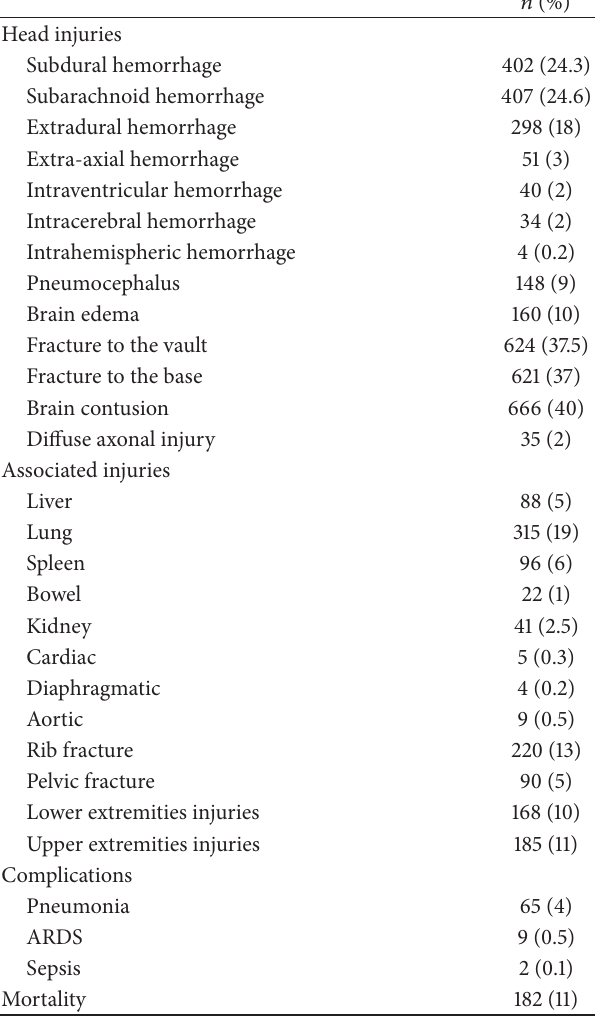
Table 2: Traumatic brain injuries and associated